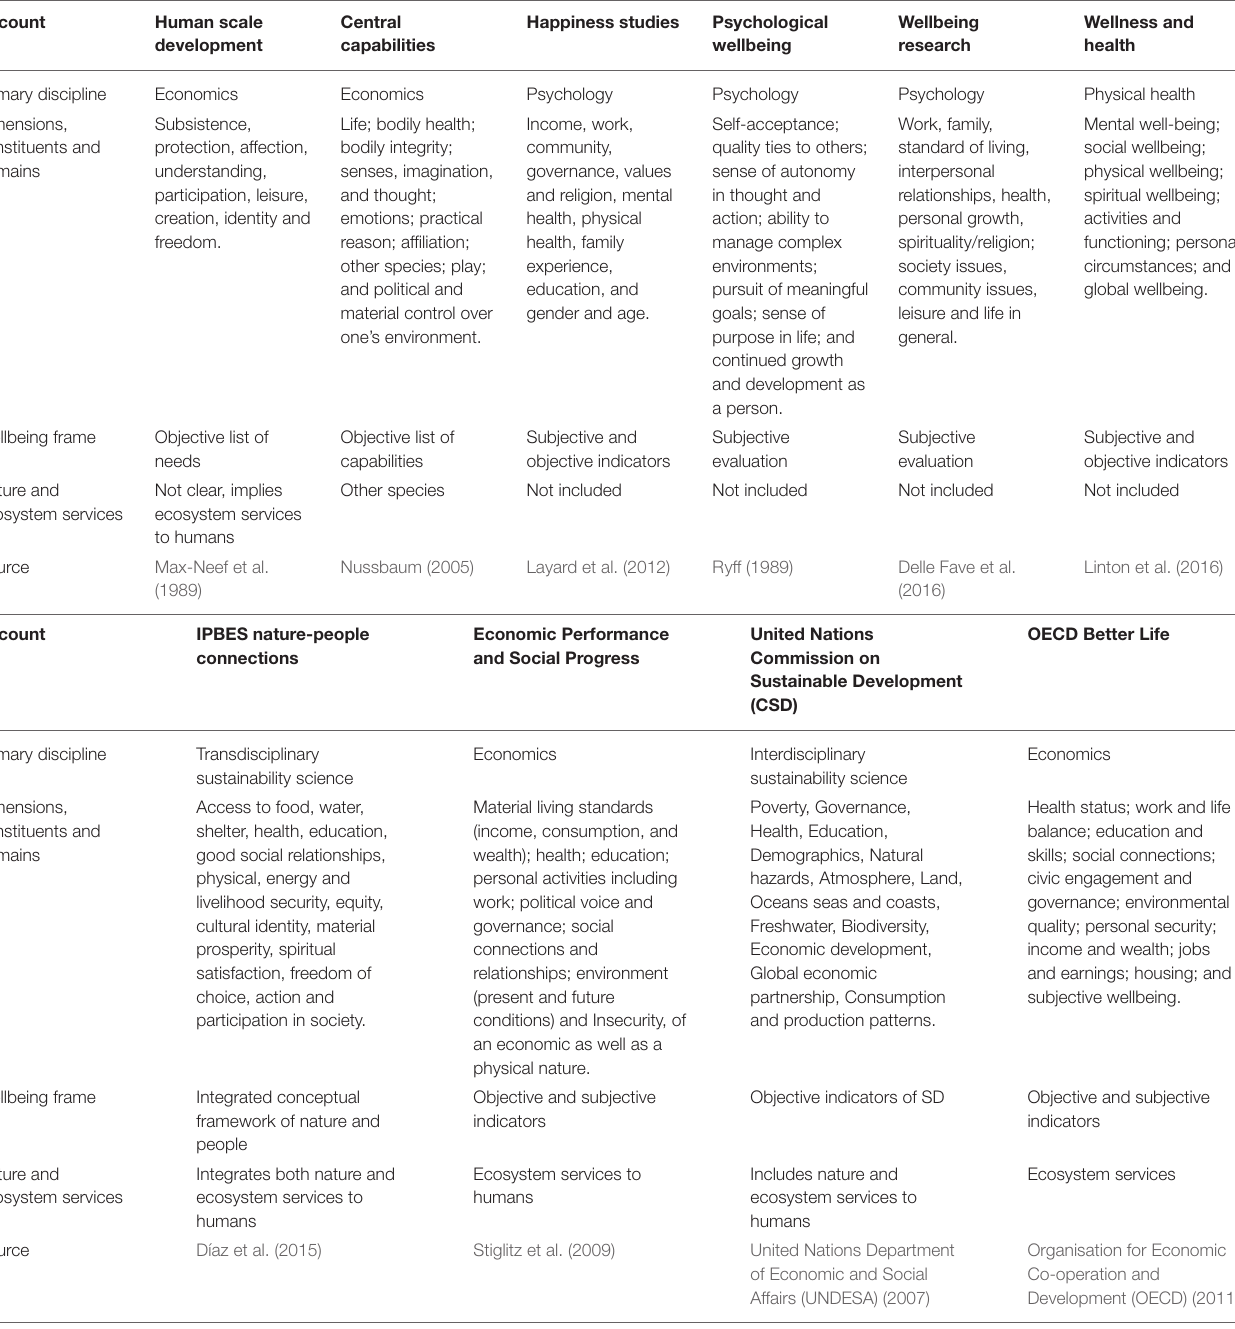
TABLE 1 | Key “objective list” accounts of multidimensional human